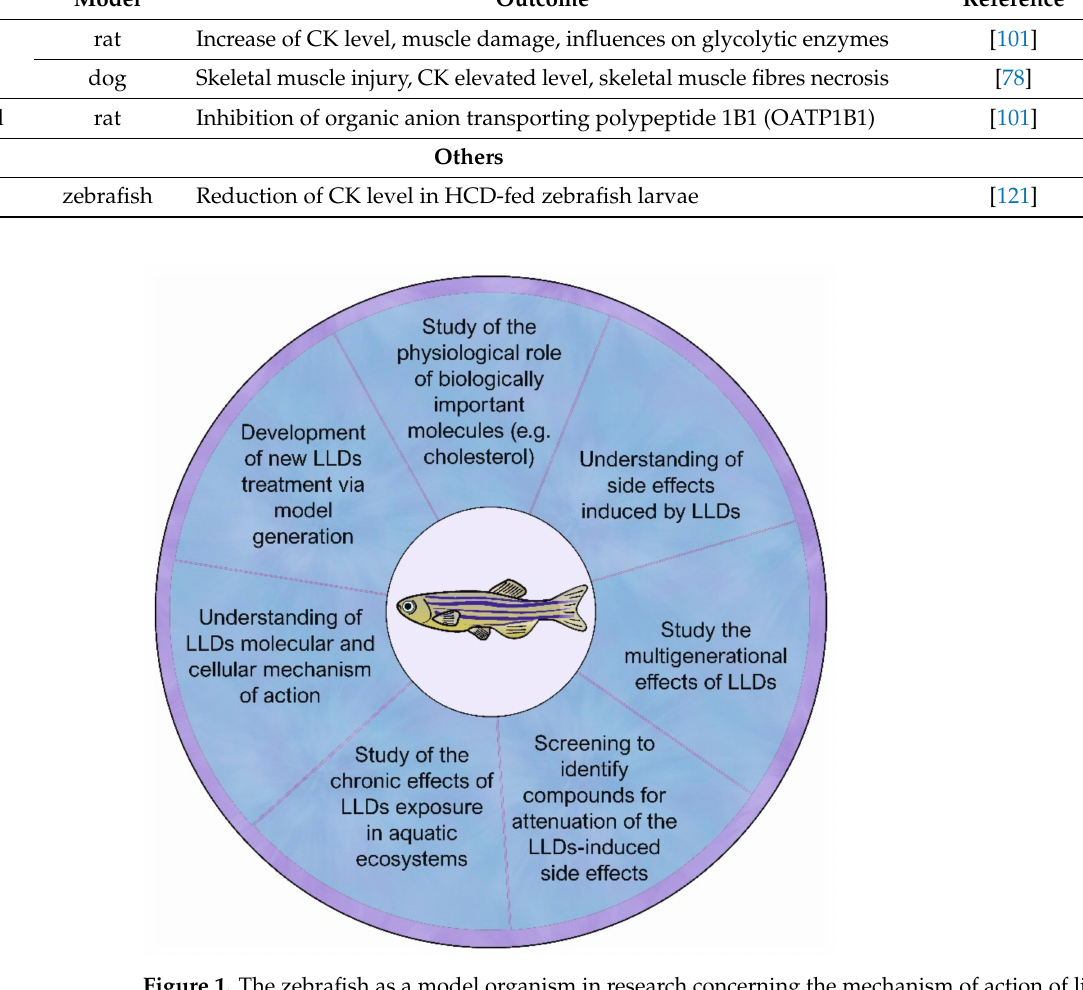
Figure 1. The zebrafish as a model organism in research concerning the mechanism of action of lipid- lowering drugs (LLDs). Zebrafish as a powerful and versatile tool used in broad biological studies can also be successfully used in research regarding lipid-lowering drugs (LLDs). These studies can cover a wide range of topics, including those related to muscle development, LLD-induced myotoxicity, the search for new, safer, and more effective therapies for hyperlipidaemia, and compounds that may prove to be dietary supplements that mitigate the effects of potential LLD-induced myotoxicity. Details can be found in the main